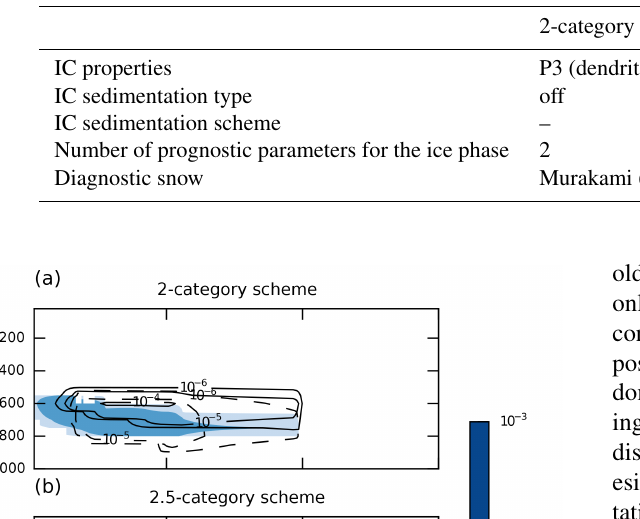
Table 1. Summary of the ice description for the three schemes mentioned in the text. Ice crystals are abbreviated by IC. P3 represents a description of particle properties according to Sect. 2. Since this analysis is focused on the different cloud ice schemes (prognostic single category vs. diagnostic two category), we use the P3 properties for ice crystals also in the 2- and 2.5-category schemes, assuring comparable fall speeds and deposition rates. Since those schemes only consider riming for snow, P3 is reduced to pure dendritic particles (i.e., F r = 0 ⇔ D gr = D cr ).